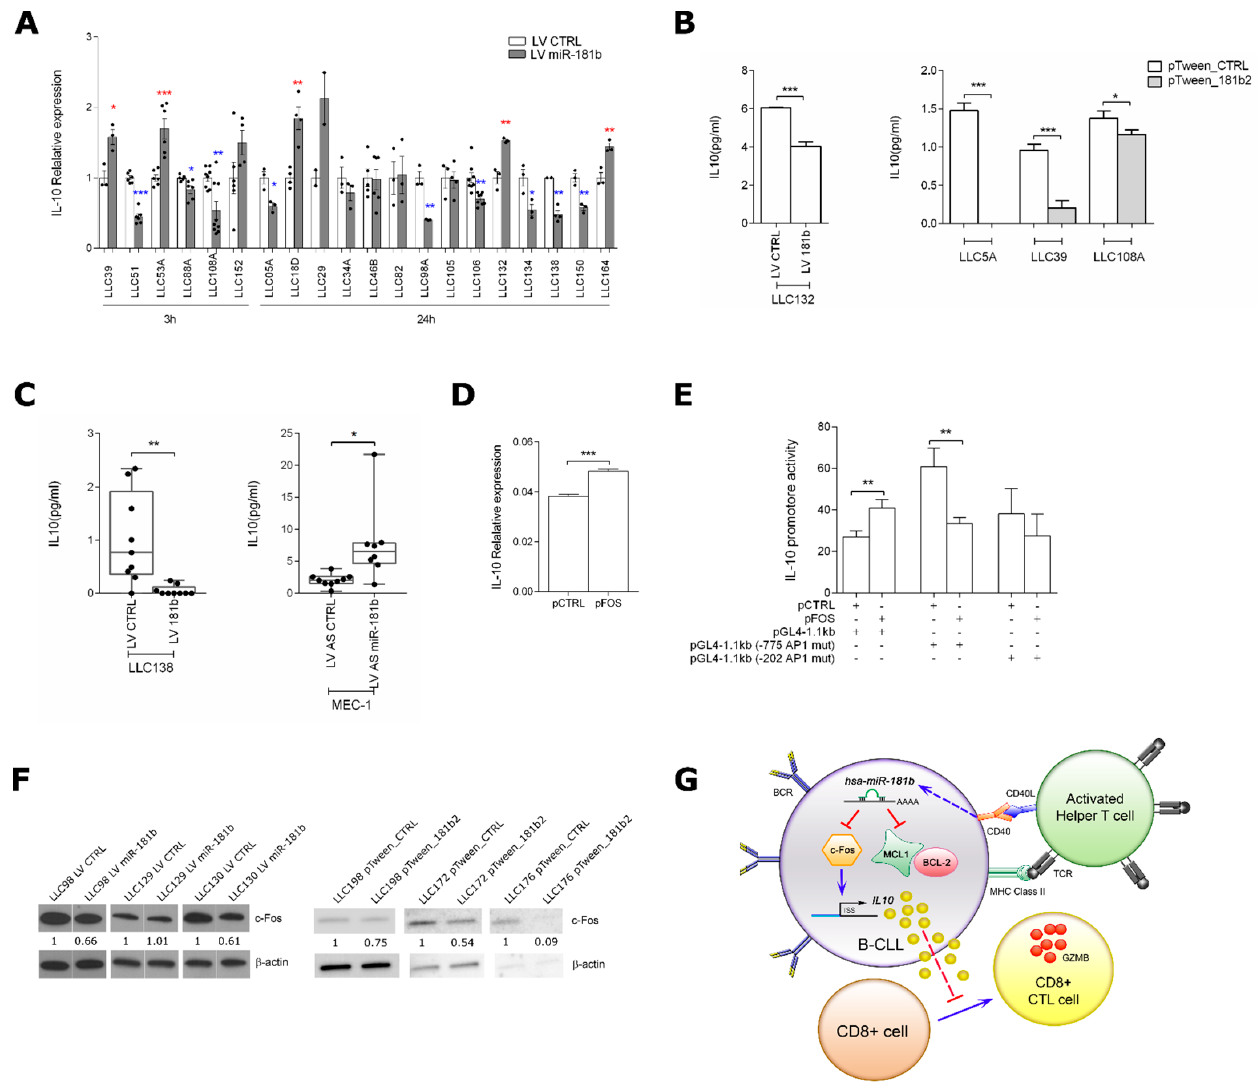
Figure 6. MiR-181b targets c-Fos in CLL cells. ( A ) Relative expression of IL10 by RT-qPCR in CLL cells after infection with either LV miR-181b or LV CTRL; IL10 expression was normalized to the endogenous reference ACTB . Data are means ± SEM and technical replicates are shown for each sample as black dot ( ● ). ( B ) ELISA determination of IL10 in the culture medium from CLL cells infected with LV miR-181b or LV CTRL, or transfected with pTween_181b2 or pTween_CTRL and activated on HeLa-CD40L cells. For LLC132 sample, IL10 was measured after three days of activation on HeLa-CD40L cells followed by eight days of culturing without HeLa cells; for LLC5A, LLC39, and LLC108A samples, IL10 was meas- ured after seven days of activation on HeLa-CD40L cells. In the culture medium from HeLa-CD40L cells alone, the IL10 was undetectable (data not shown). Data are mean ± SEM. ( C ) ELISA determination of IL10 in the culture medium from a CTL assay with autologous (LLC138) or allogenic (MEC-1) T-cells. PBMC from LLC138 patient were cultured in a two- round of CTL assay; MEC-1 cells were mixed with T cells from healthy donor 28 (THD28), as described in the experiment reported in Figure 5D. IL10 release was measured in medium after one (MEC-1) or two (LL138) 8-days cycles following B- T cells mixing. Data are median ± range of experimental triplicates. ( D ) Relative expression of IL10 (by RT-qPCR) in trans- fected MEC-1 cells after 24 h with either a c-Fos-expressing plasmid (pFOS) or a control plasmid (pCTRL). Data are mean ± SEM. ( E ) Relative luciferase activity of the IL10 promoter in co-transfected MEC-1 cells with pFOS (or pCTRL) and a PGL4 luciferase reporter vector containing the IL10 promoter region in native form or mutated at one of the two AP-1 transcription factor binding sites. The data were normalized to Renilla luciferase activity. Data are mean ± SEM. ( F ) West- ern blot of c-Fos in purified CLL cells from six CLL patients infected with either LV miR-181b or LV CTRL, or transfected with either pTween_181b2 or pTween_CTRL. β -actin was used as loading control. Densitometric values normalized to β - actin expression are reported. ( G ) Schematic representation of the proposed miR-181b mechanism of action. The enhanced